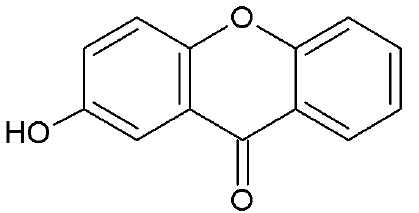
Figure 2. Structure of 2-hydroxyxanthone, oxygenated